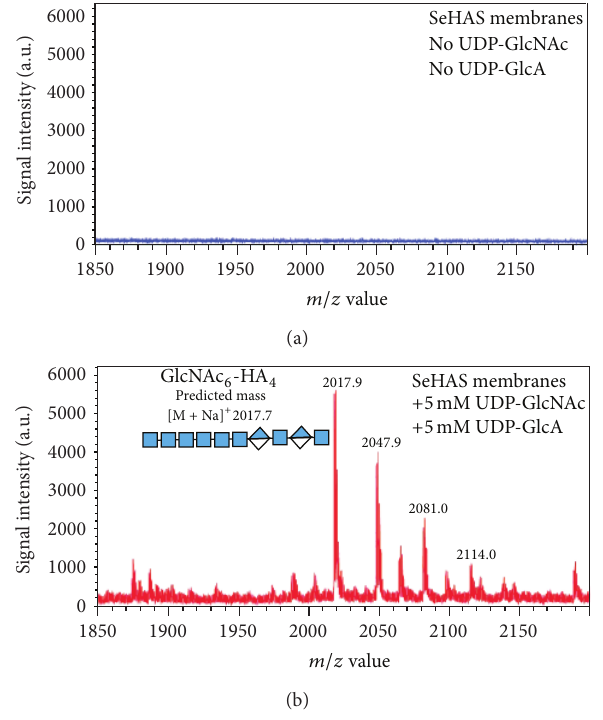
Figure 5: Mass spectral evidence for chitin-HA in HA made by SeHAS. Empty vector (a) or SeHAS (b) membranes were preincu- bated for 30 min with UDP-GlcNAc, UDP-GlcUA was added, and incubation proceeded for several minutes. The membranes were heated to release HA and subjected to two cycles of Folch extraction. Extracted HA products were speed vacuum concentrated, digested with ovine testicular hyaluronidase, and the resulting oligomers were subjected to affinity selection over carbograph. Eluted material was surveyed by MALDI-TOF MS to identify “hybrid” fragments corresponding to a chitin oligomer cap linked to HA disaccharides, such as the GlcNAc 6 -(GlcUA-GlcNAc) 2 species